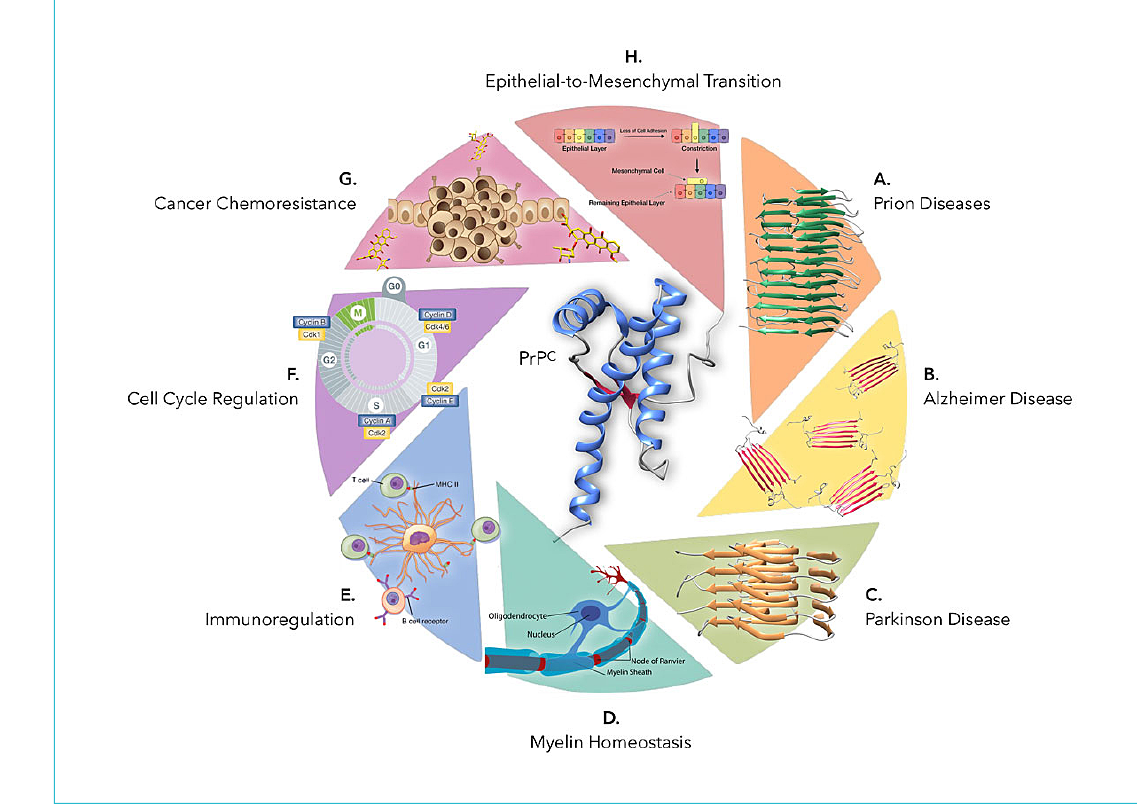
Figure 1: The physiological and pathological processes in which PrP C (PDB 2LFT) may play a role . In addition to serving as a substrate for PrP Sc replication (model depicted in A from [149]), the protein has also been reported to act as a receptor for Aβ oligomers (B, PDB 6RHY) and misfolded α-synuclein (C, PDB 2N0A). Surprisingly, PrP C has also been involved in myelin homeostasis (D), immunoregulatory processes (E) and cancer, mainly at the levels of cell cycle regulation (F), drug resistance (G) and epithelial-to-mesenchymal transition (H), among oth-